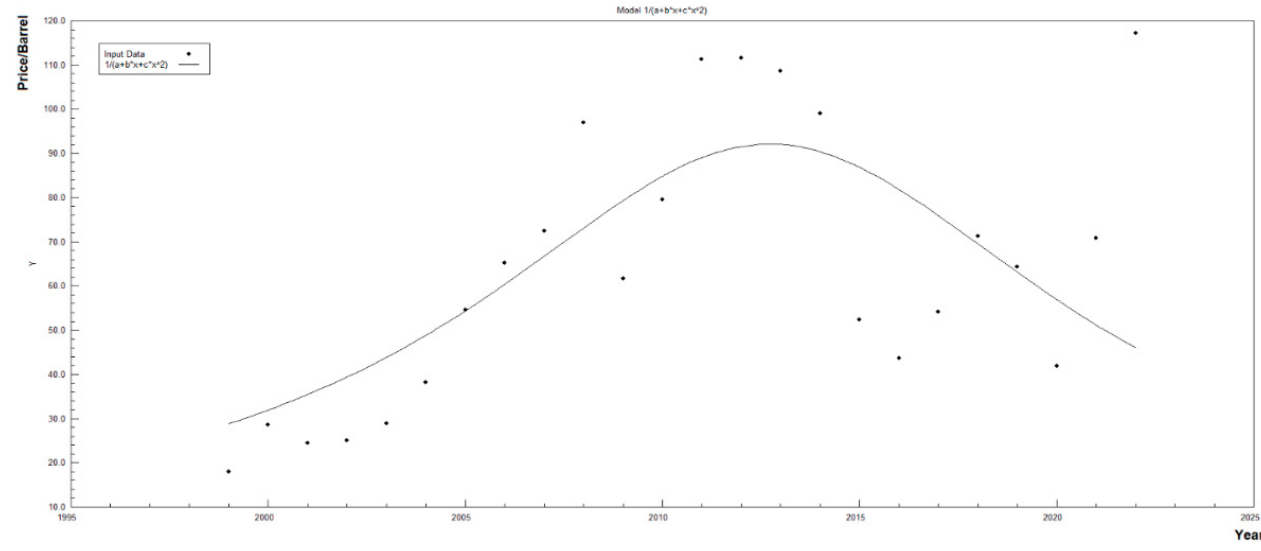
Figure 6. Model definition graph: Y = 1/(a + b · x + c · x 2 ). As can be seen, the identified model has a 99% confidence; this shows that it